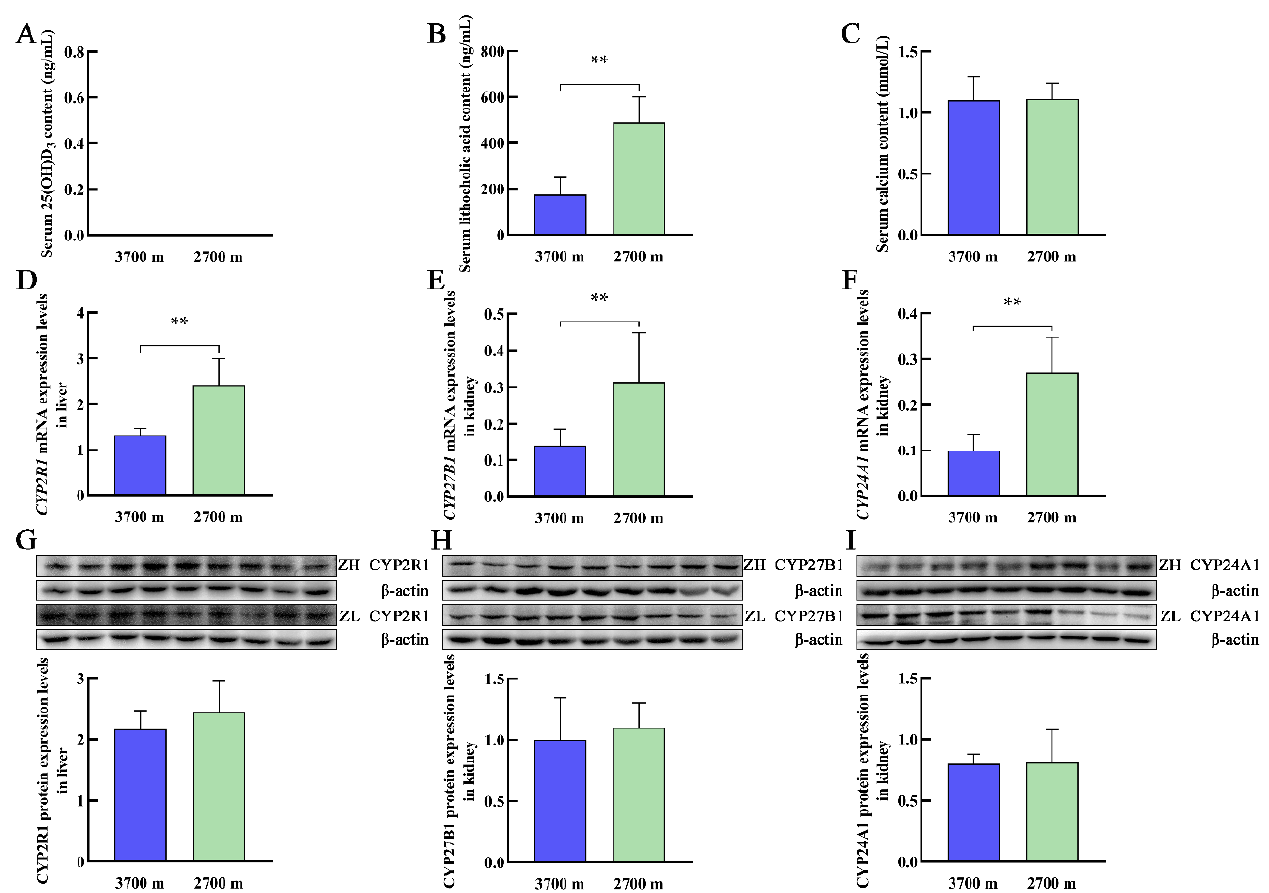
Figure 2. Serum levels of 25(OH)D 3 , lithocholic acid, and calcium and the expression levels of CYP2R1, CYP27B1, and CYP24A1 in the liver and kidney of plateau zokor at different altitudes. ( A – C ) represent the serum levels of 25(OH)D 3 , lithocholic acid, and calcium, respectively. The mRNA ( D ) and protein ( G ) expression levels of CYP2R1 in the liver. The mRNA ( E ) and protein ( H ) expres- sion levels of CYP27B1 in the kidney. The mRNA ( F ) and protein ( I ) expression levels of CYP24A1 in the kidney. ZH and ZL represent the plateau zokor at elevations of 3700 m and 2700 m, respec- tively. ** p < 0.01. (original Western blot figures are in Figure S2.).